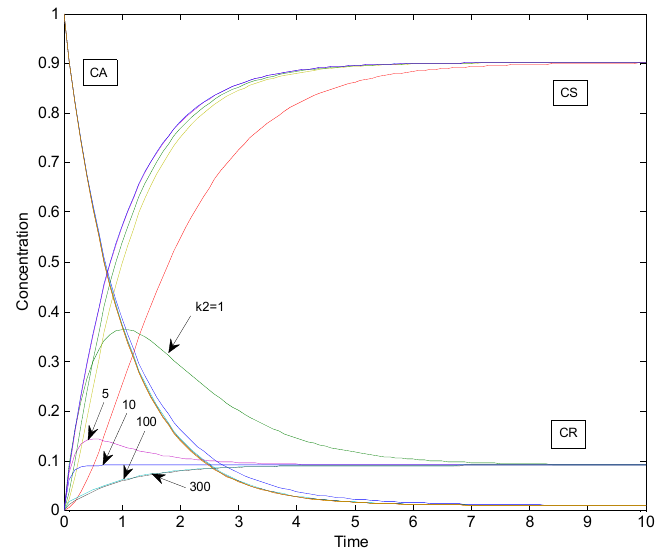
Figure 3. Concentration profiles of the general case of consecutive reactions with parameters: k 1 = 1, k 2 = 1, 5, 10, 100 and 300, K 1 = 10 and K 2 = 10.